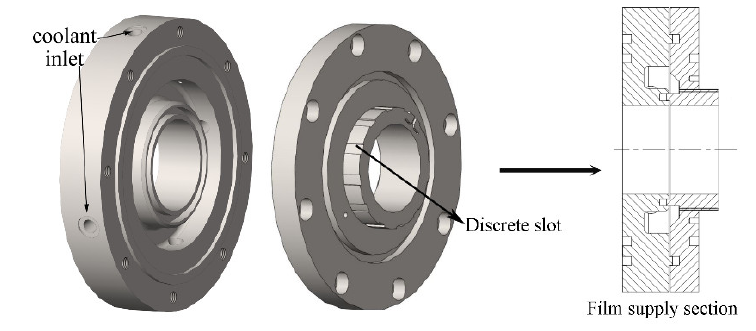
Figure 2. Conformation of the film supply section.